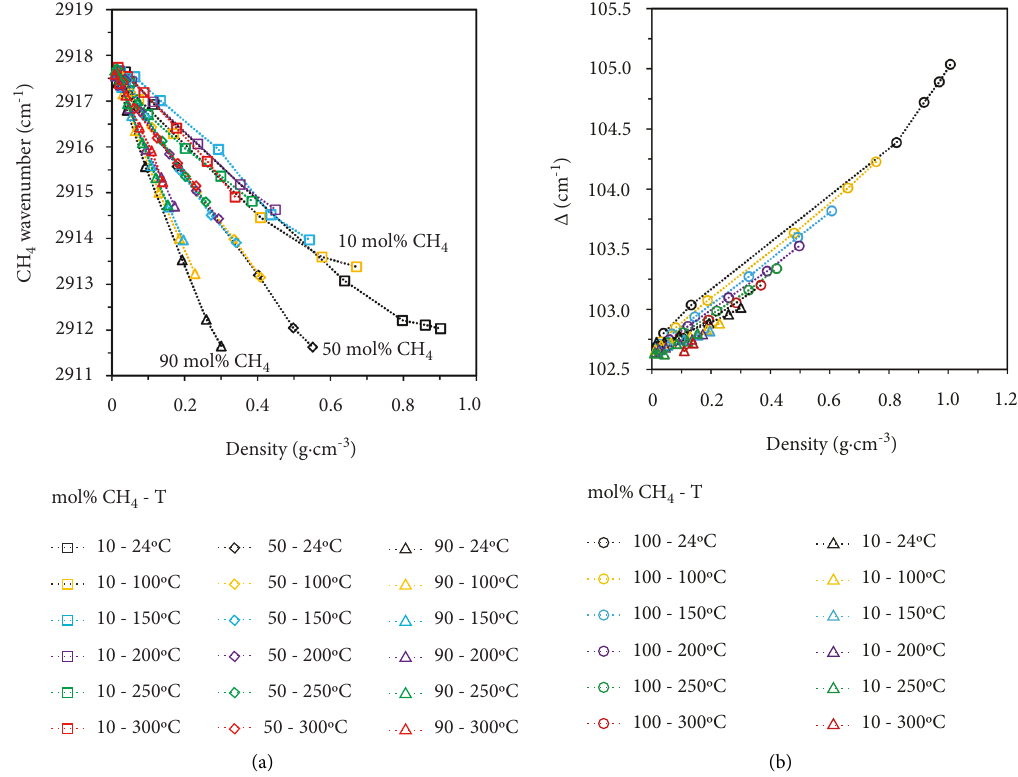
Figure 10: Effect of temperature on the variation of (a) the υ density of CO 2 -CH 4 mixtures.